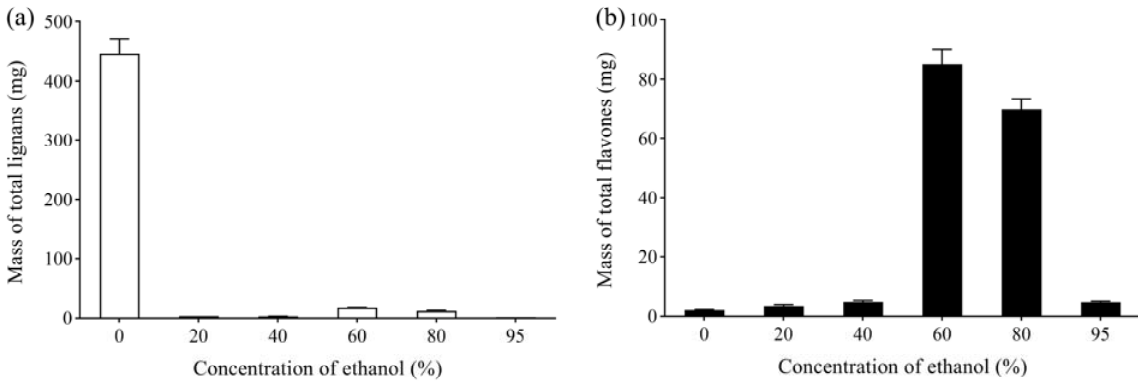
Figure 5. ( a ) Effect of ethanol concentration on the mass of total lignans in P ‐ TLF; ( b ) effect of ethanol concentration on the mass of total flavonoids in P ‐ TLF.